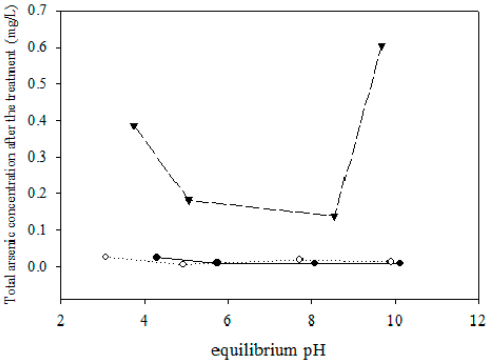
Figure 21. Total As concentrations remaining in mine-water effluent from Horobetsu mine treated using SOJR gel ( ● ), seaweed gel ( ◇ ) and the conventional coprecipitation method ( ▼ ) (in which ferric hydroxide was precipitated from the acidic mine water containing large amounts of iron when magnesium oxide was added) [15]. (With permission for reuse from The Mining and Materials Processing Institute of Japan).